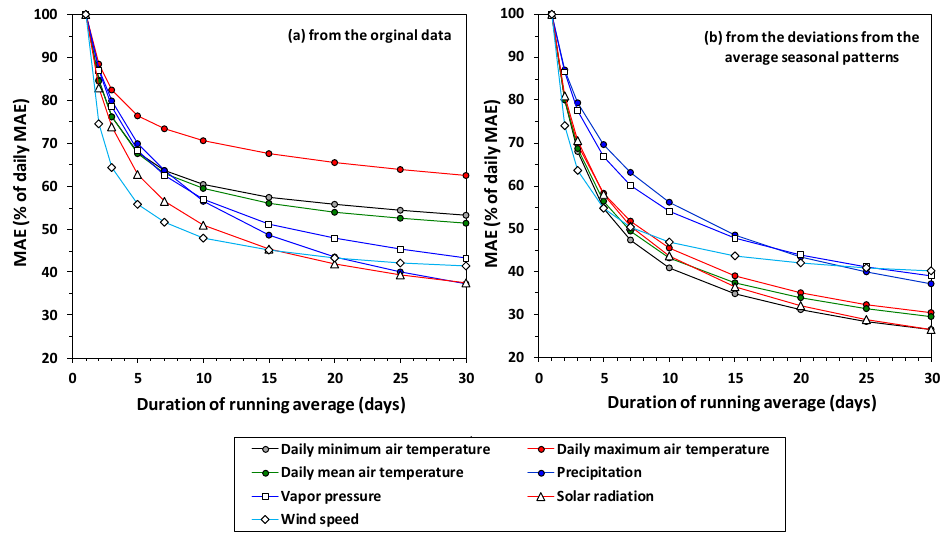
Figure 7. Changes of mean absolute error (MAE) with the duration of running average ( a ) for the original data and ( b ) for the error in deviations from the long-term average seasonal patterns. The daily observations for precipitation are from 1948 to 2016, and other observations are from 1953 to 2005.